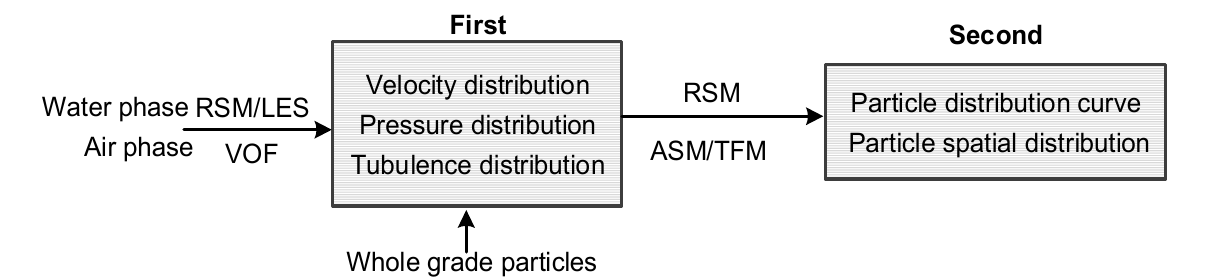
Figure 1. Modelling strategy for numerical tests.